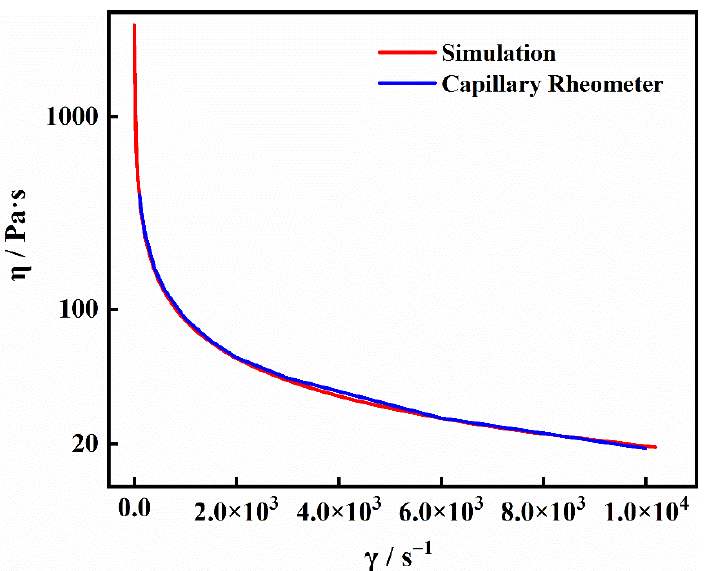
Figure 6. Simulated and experimental relationship relationships between shear viscosity and shear rate of PP/Fe 3 O 4 composites with Fe 3 O 4 content of 5 wt.% at temperature of 210